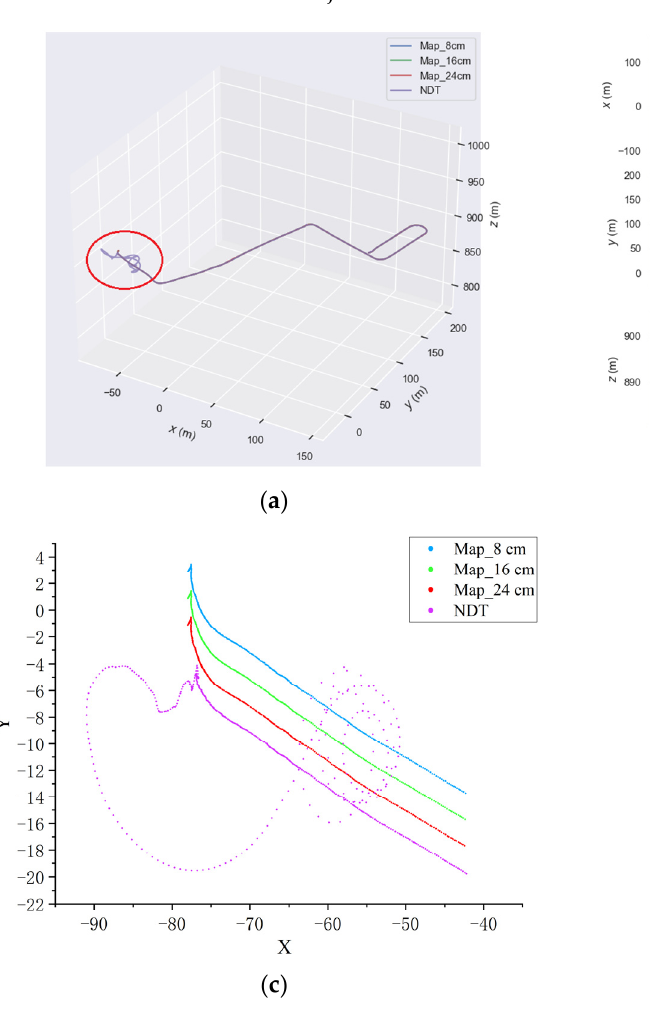
Figure 11. ( a ) Underground mine tunnel trajectory; ( b ) Underground mine tunnel trajectory from XYZ view; ( c ) Projection of the trajectory inside the red ellipse in ( a ) onto XY plane; ( d ) Projection of the trajectory inside the red box in ( b ) onto XY plane.